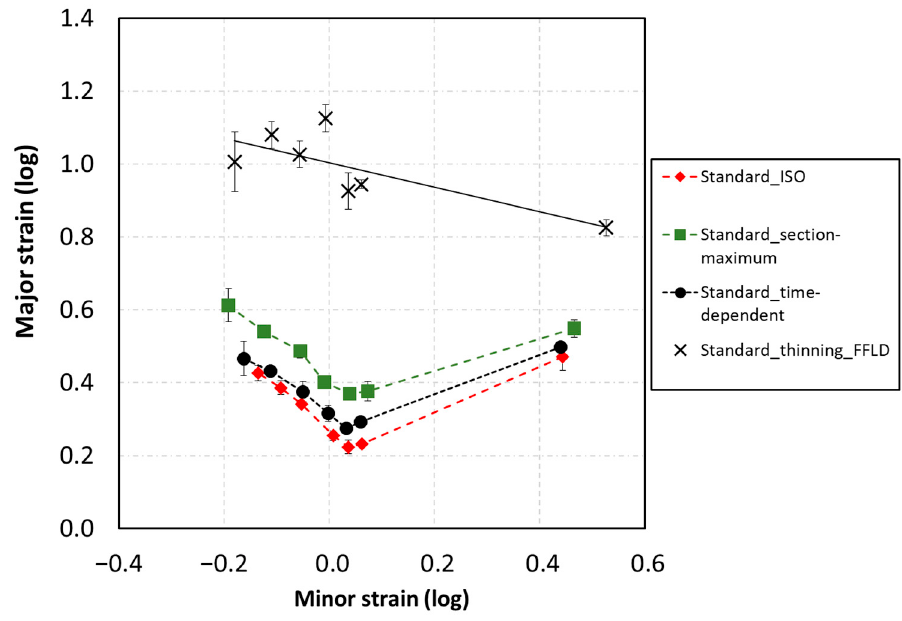
Figure 7. Forming limit diagram of 22MnB5 determined according to ISO standard, time-dependent, section maximum and thinning methods; standard specimens—comparison of the evaluation methods.